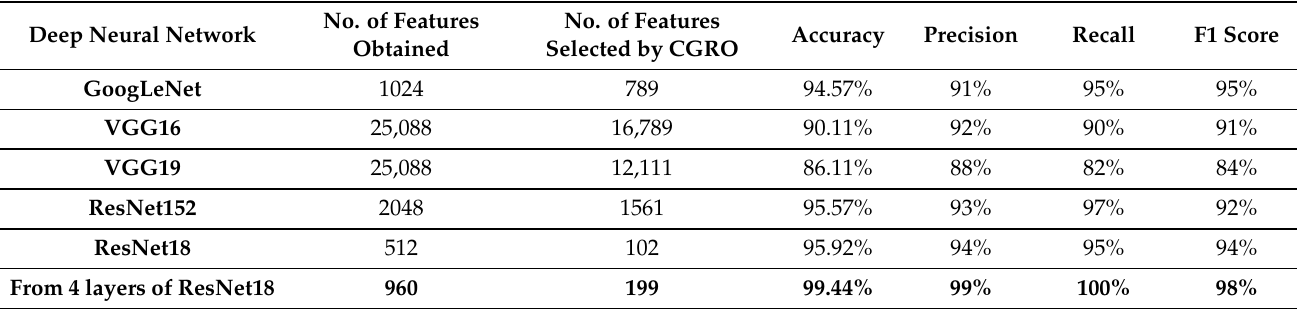
Table 4. Results obtained on X-Ray 2-class dataset using different models. Different parameters and obtained results with 4 layers features of ResNet18 are highlighted boldly in the table.